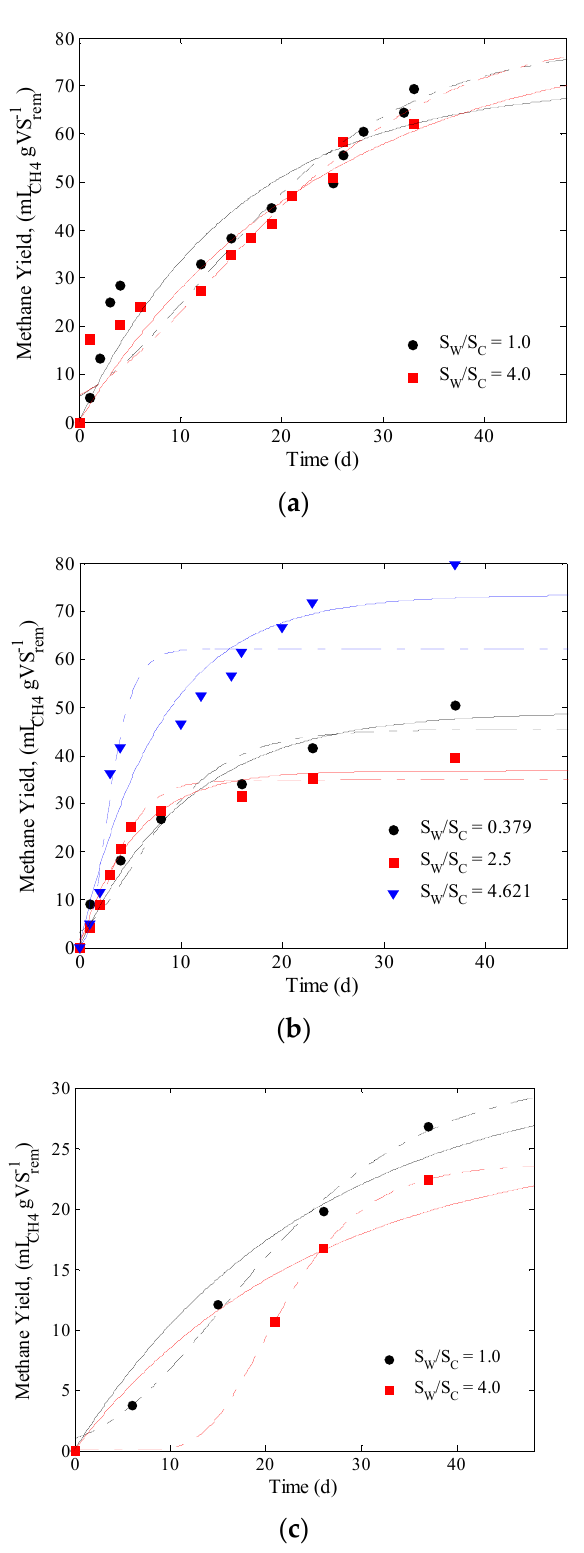
Figure 1. Methane yield profile obtained in the anaerobic co-digestion of raw cheese whey and coffee pulp residues at different substrates ratio, ( a ) pH = 6.0, ( b ) pH = 7.0, and ( c ) pH = 8.0.